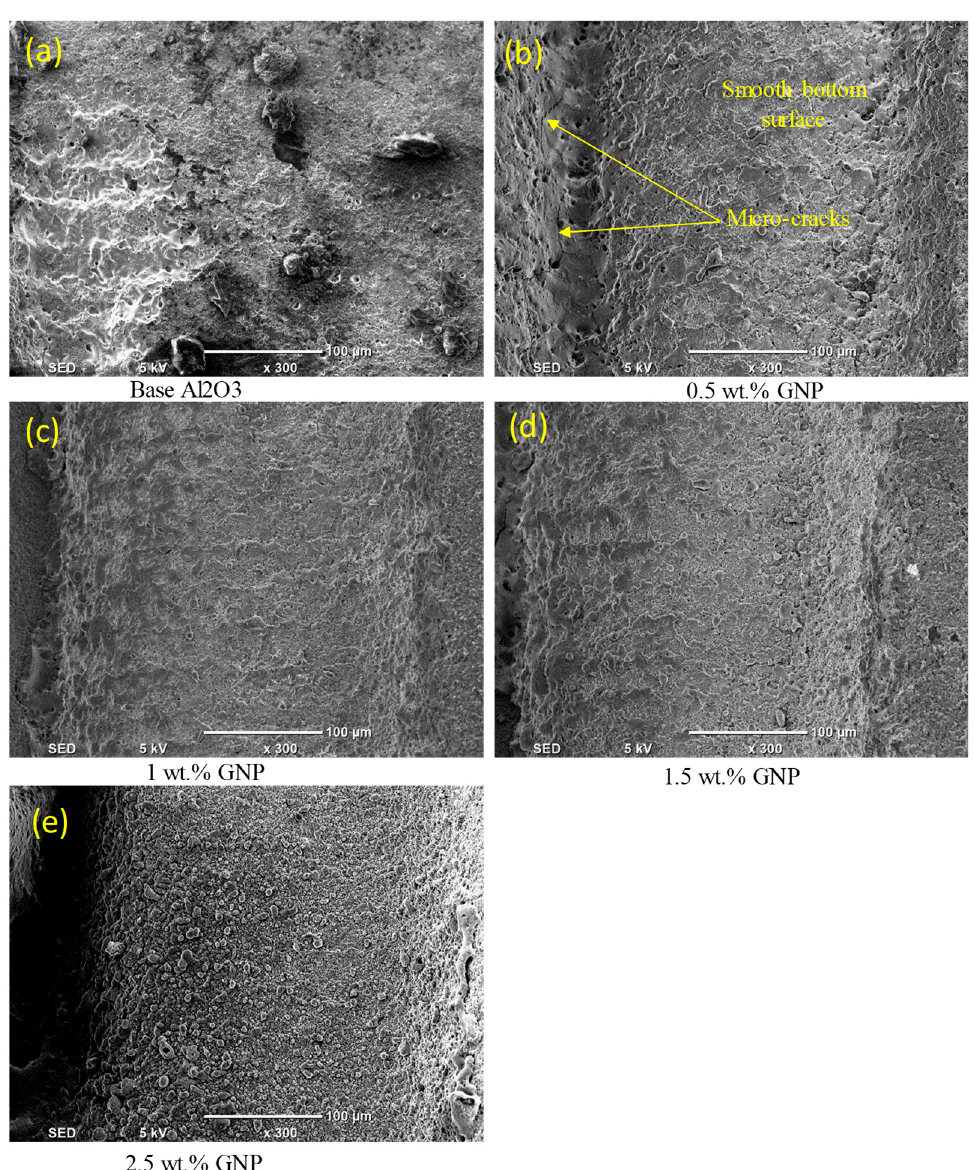
Figure 12. Zoomed-in images of the selected regions (1 – 5) shown in Figure 11 .